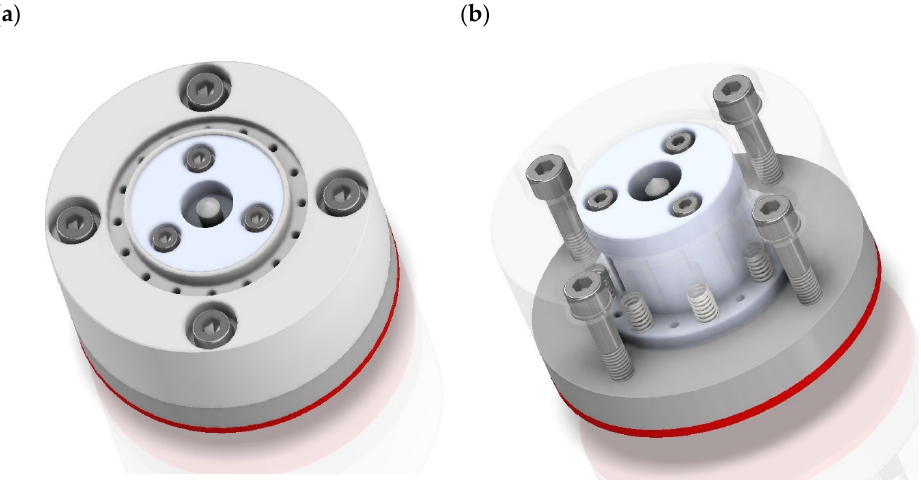
Figure 3. The 3D digital model of a dual-tool grinding head: ( a ) external body view; ( b ) internal body view.